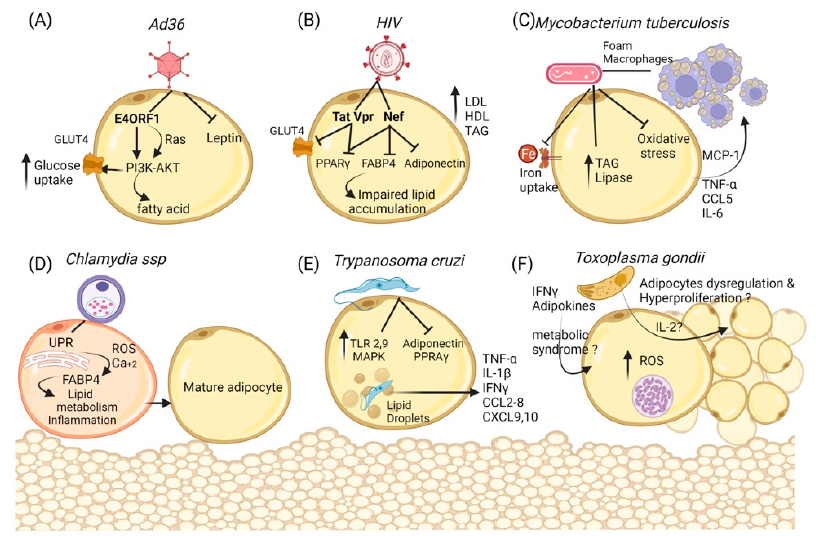
Figure 2. Cellular and metabolic changes in adipocytes during infections. ( A ) Ad36 regulates the activation of Phosphoinositide 3-kinase (PI3K) by the recruitment of P13K to the membrane, PI3K-AKT leads to cellular glucose uptake by the glucose transporter Glut4 and could induce the de novo synthesis of fatty acids despite the down-regulation of the Insulin Receptor. Moreover, the inhibition of Leptin may increase lipid accumulation and the prevalence of obesity. ( B ) HIV proteins Vpr, Tat, and Nef participate as repressors of PPAR- γ and its target, such as GLUT4, besides Vpr expression, thus accelerating lipolysis and insulin resistance as well as preventing the maturation of adipocytes. ( C ) Mycobacterium tuberculosis can use adipose tissue as a reservoir and as macrophages, inducing lipogenic metabolism that can accumulate lipids (foam macrophages). Furthermore, adipocytes regulate inflammation by reducing oxidative stress in a decreased iron uptake manner, but augmenting pro-inflammatory cytokines and chemokines that recruit cells similar to macrophages. Additionally, the synthesis of triacylglycerol and lipase is increased to dispose of free fatty acids. ( D ) Chlamydia ssp infection increases the unfolded protein response and the guides to ROS production and Ca++ release; this could lead to FABP4 activity in adipocytes. Moreover, the expression of adipogenic markers is accompanied by lipid droplet accumulation, suggesting their transformation into differentiated adipocytes. ( E ) Trypanosoma cruzi infection dysregulates some proteins in the adipocyte, reducing adiponectin and PPAR- γ , but also signal molecules that stimulate inflammation such as Toll-like receptors (TLR-2 and -9). Additionally, cultured adipocytes presented a higher activation of the MAPK pathway in cultured adipocytes. Cytokines (TNF- α , IL-1 β , IFN- γ ) and chemokines (CCL2-CCL8 and CCL12), as well as the levels of CXCL9 and CXCL10, were markedly elevated in the adipose tissue of acutely infected mice. ( F ) Toxoplasma gondii bradyzoites use the adipose tissue as reservoirs; the infection with T gondii can induce oxidative stress and the subsequent inflammatory response. In addition, several cytokines, such as IL-2, could affect the adipocyte tissue and alter their metabolism or promote cell proliferation and hypertrophy as well the presence of Interferon-gamma and adiponectin chemerin in the serum, thus encouraging